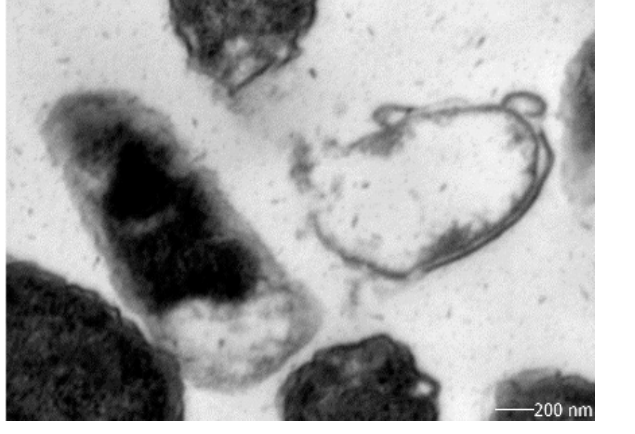
Figure 2. Lethality curve of A. baumannii upon treatment with γ -Al 2 O 3 NPs.